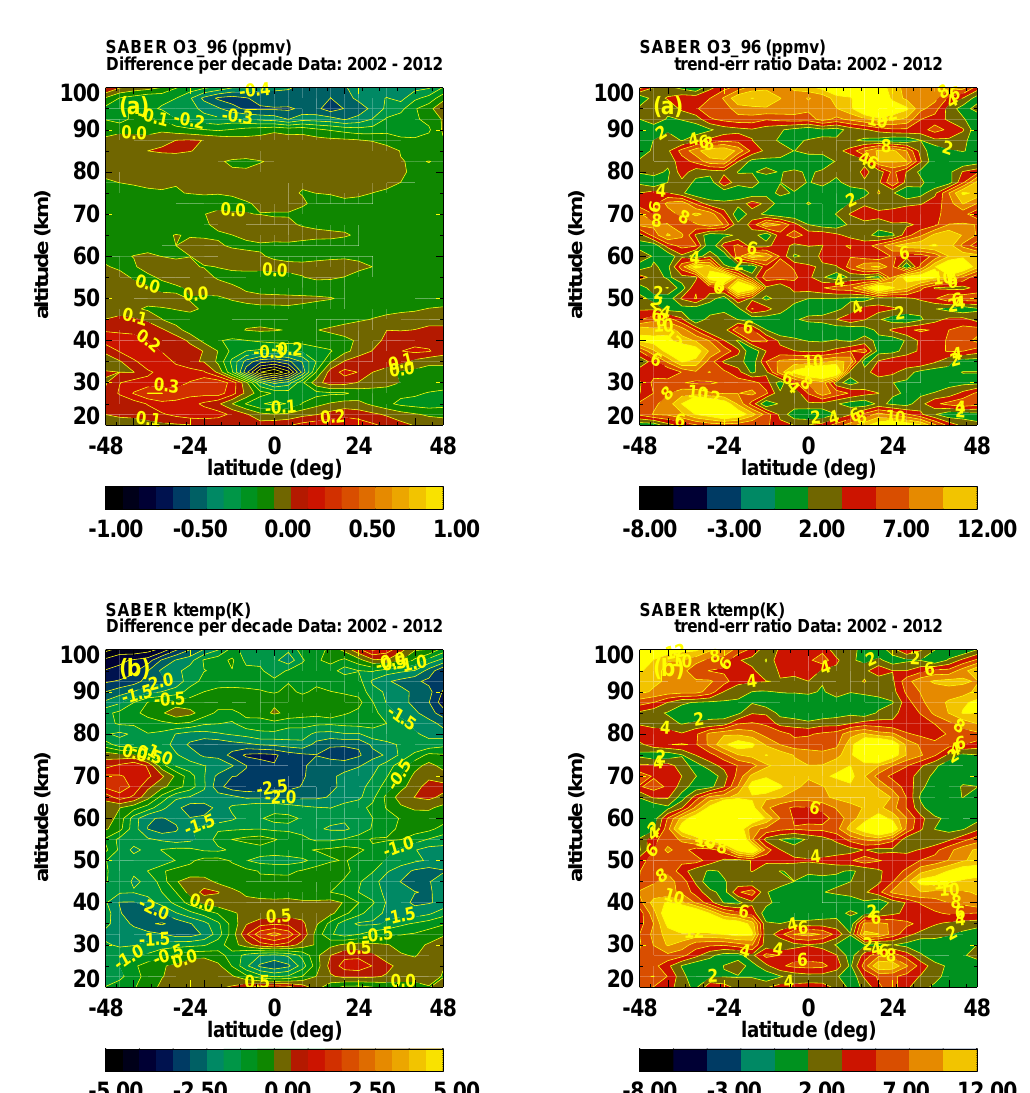
Figure A1. Top row: ozone trends (top left) and ratios to their respective uncertainties (top right). Bottom row: corresponds to top row, but for